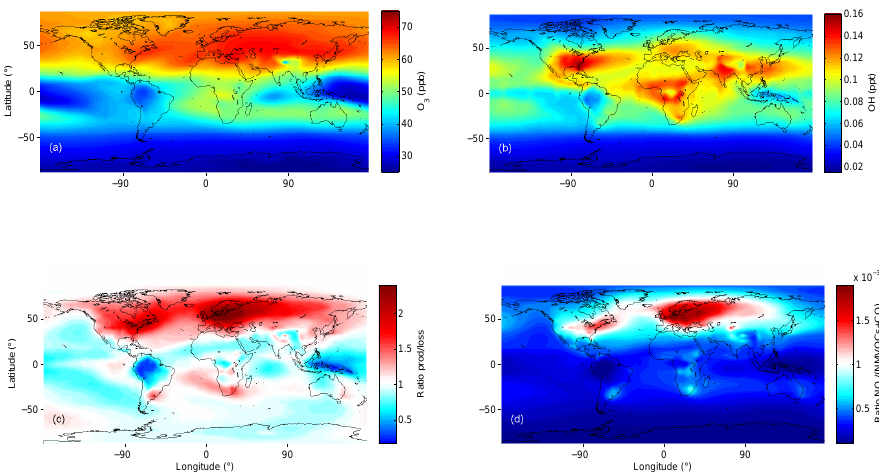
Figure 3. Results from the REF-C2 simulation, 1960–1969 average, 500hPa. (a) Ozone; (b) OH; (c) ratio of ozone production over loss; (d) ratio of NO x : NMVOCs + CO.